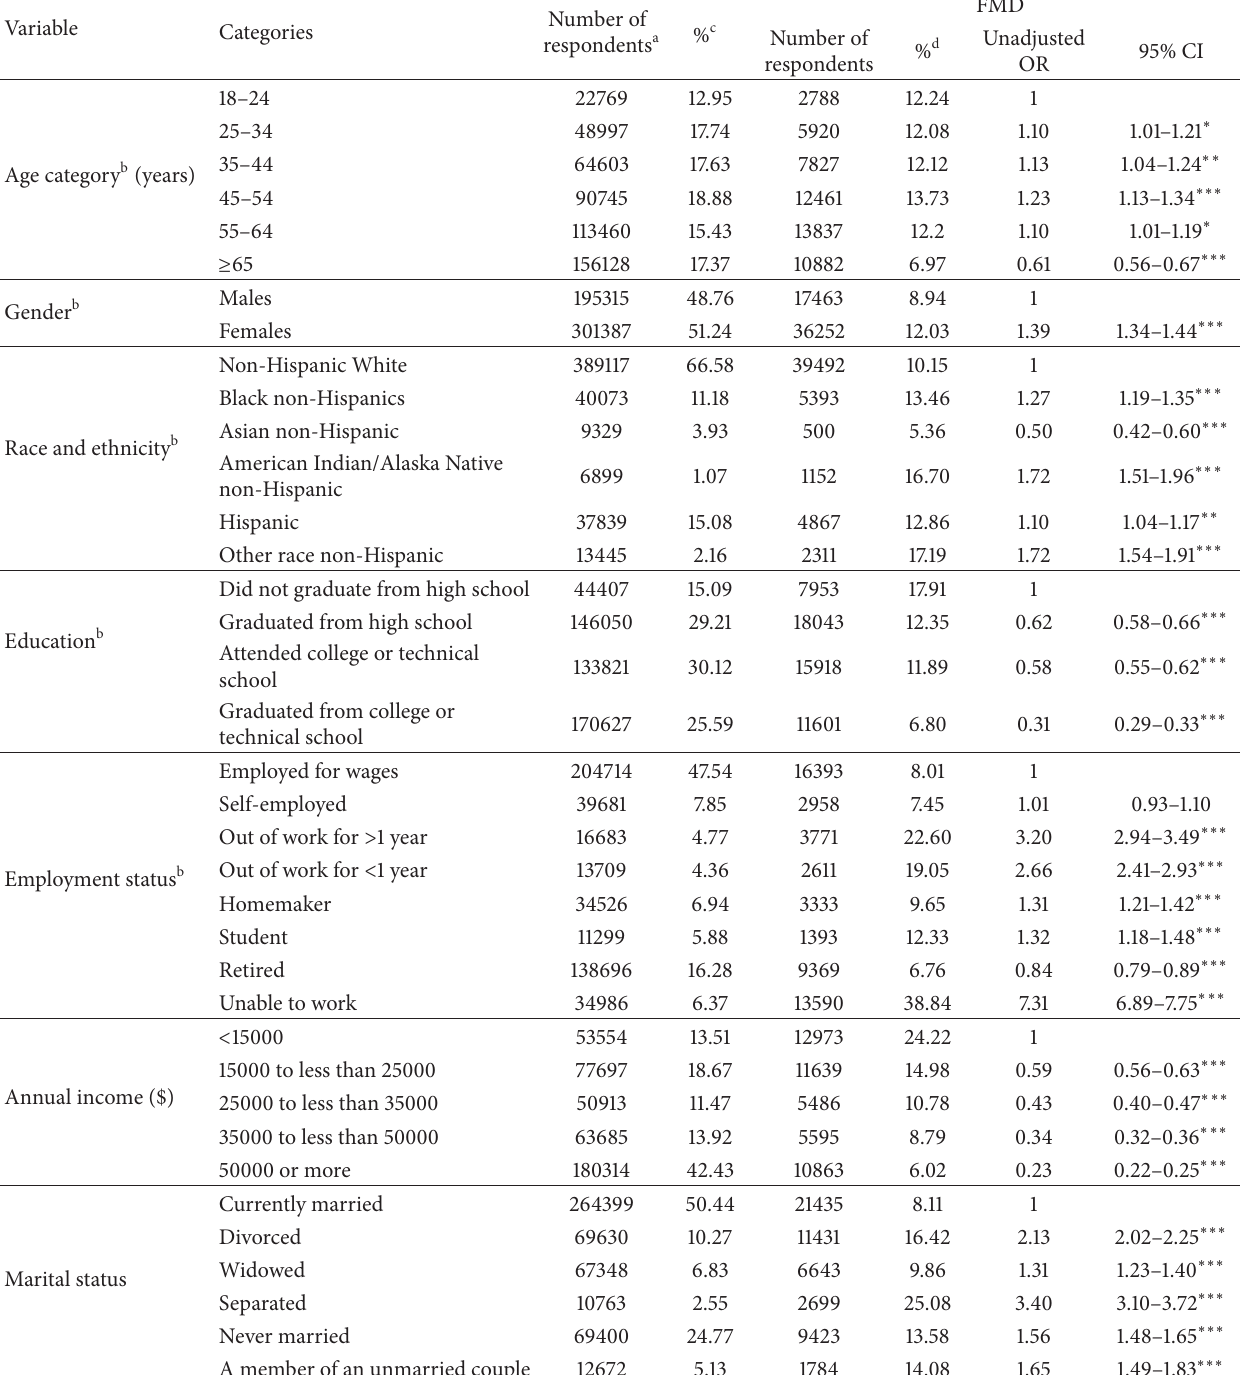
Table 2: Relationship of demographic characteristics with FMD among adults in the United States, BRFSS